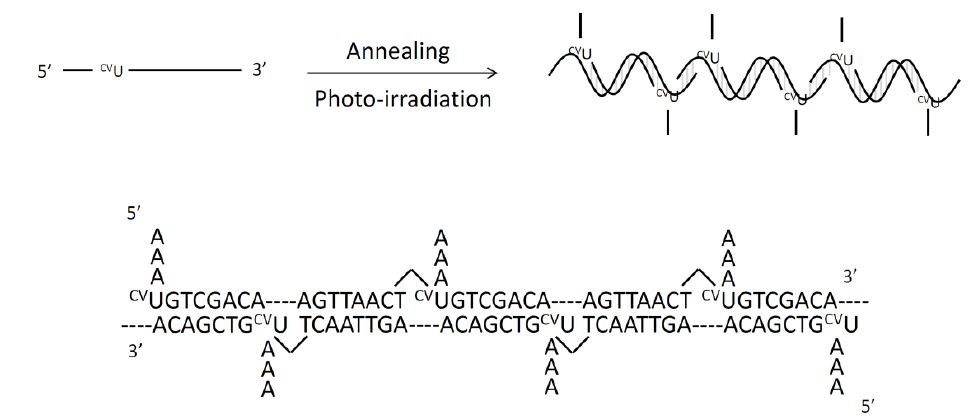
Figure 7. Schematic illustrate of self-assembled